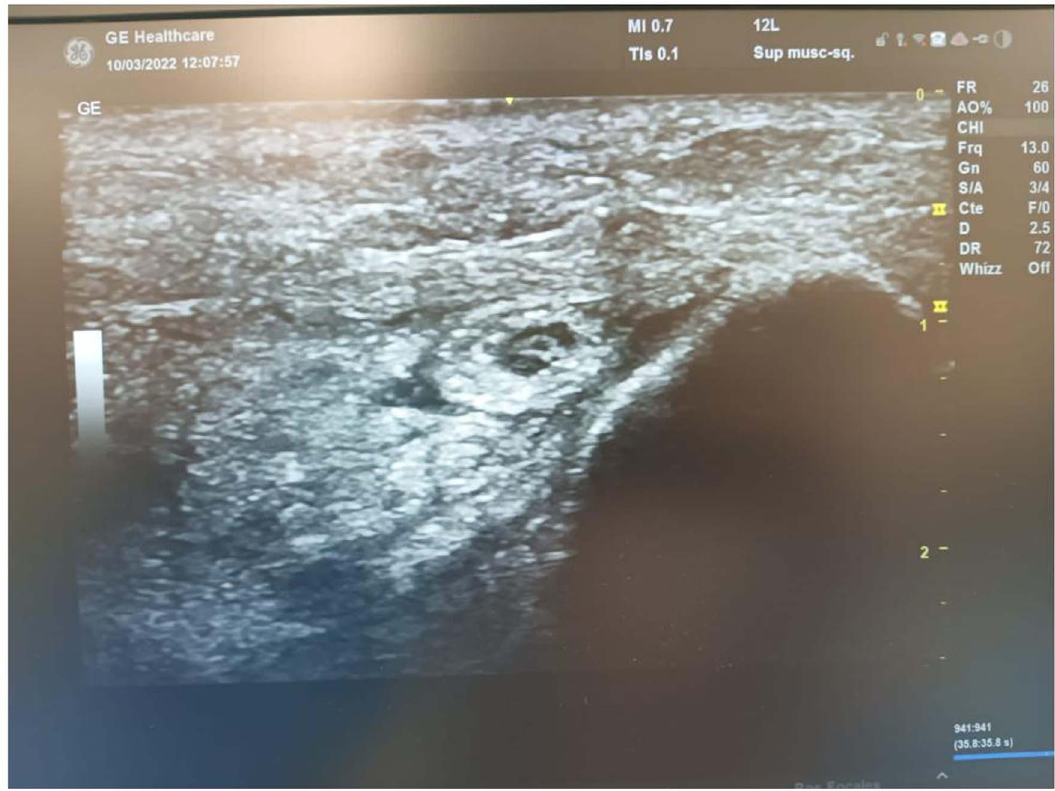
Figure 3. A transverse sonogram showing the compression site of ulnar nerve at medial elbow.